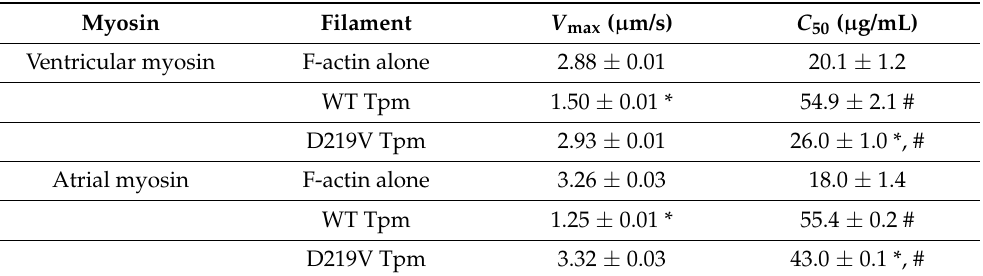
Table 2. The effects of the D219V Tpm mutation on the dependence of the sliding velocity of the